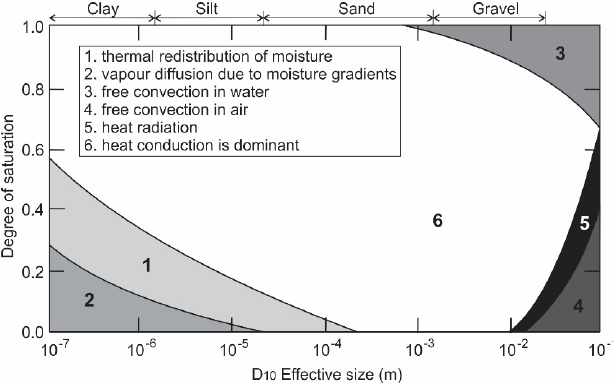
Figure 1. Main heat transfer processes in soils (after [19]).